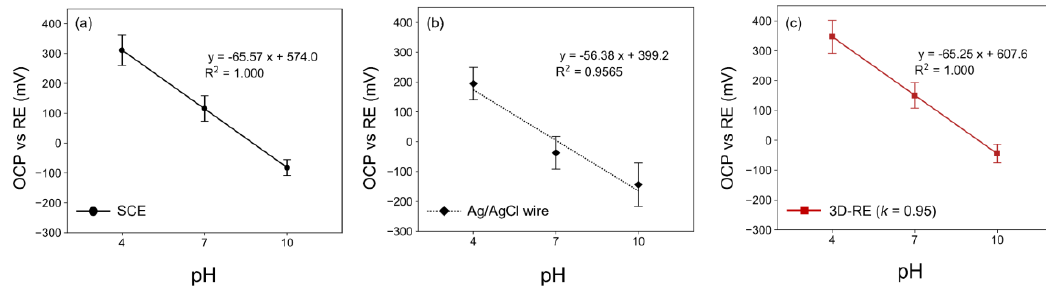
Figure 10. Potential responses ( n = 3) of iridium oxide (IrO x ) electrodeposited on inkjet-printed Au electrode (IrO x |Au) in various standard pH buffers and the corresponding linear regression plots. Responses were measured against different reference electrodes: ( a ) commercial SCE, ( b ) Ag|AgCl pseudoreference electrode, and ( c ) 3D-RE ( k = 0.95). For the linear regression equations, y = OCP in mV and x = pH.